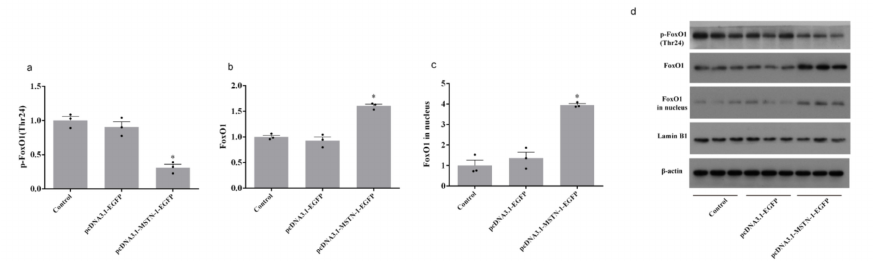
Figure 10. Overexpression of mstn-1 decreases the phosphorylation of phosphor-Forkhead box O1 (FoxO1) as well as increases the nuclear accumulation of FoxO1. ( a ) Western blot analysis of the phosphorylation level of FoxO1. Histogram represents the ratio between the phosphorylated protein and the total amount of FoxO1. ( b ) Western blot analysis of FoxO1. Histogram represents the ratio between FoxO1 and β -actin. ( c ) Western blot analysis of FoxO1 in nucleus. Histograms represent the ratio between the FoxO1 in nucleus and Lamin B1 (as reference protein in nucleus). ( d ) E ff ect of mstn-1 overexpression on the protein expression of p-FoxO1 (Thr24), FoxO1, and FoxO1 in nucleus. Results are represented as mean ± SE ( n = 3). * means significantly di ff erent compared with control ( p < 0.05).